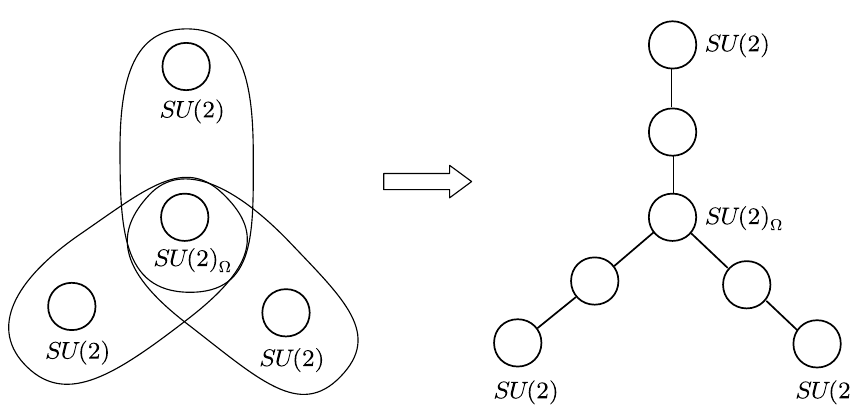
Figure 9 . Extended Dynkin diagram of E 6 , viewed from three triality